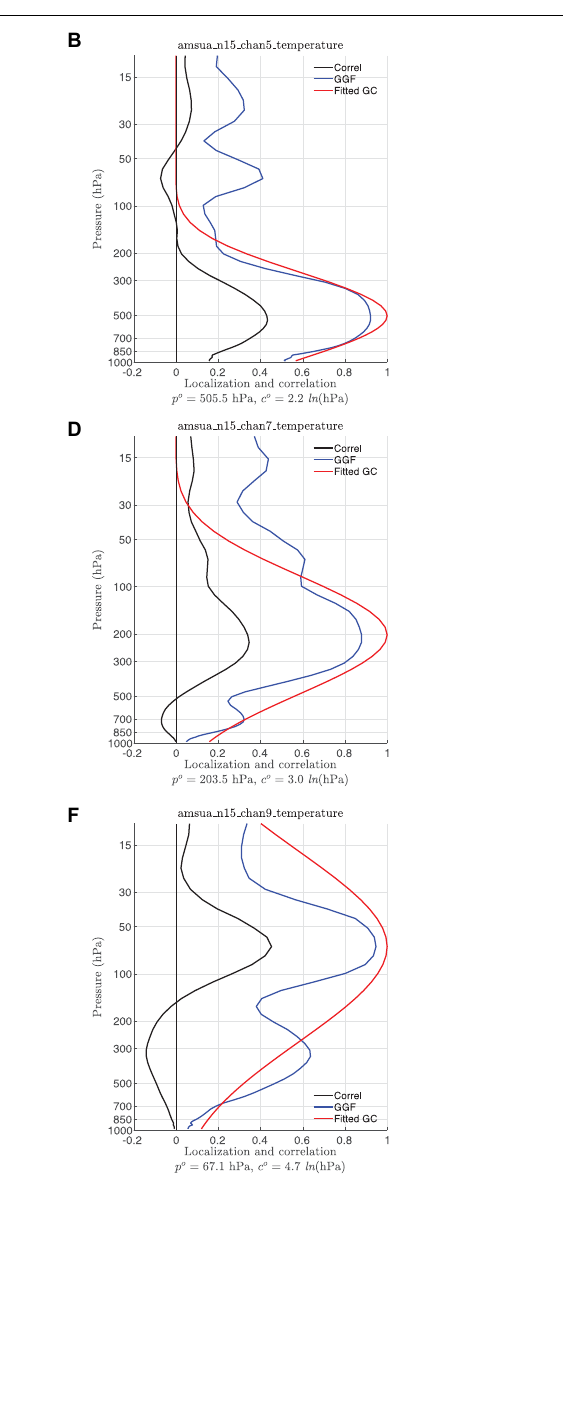
Frontiers in Earth Science |